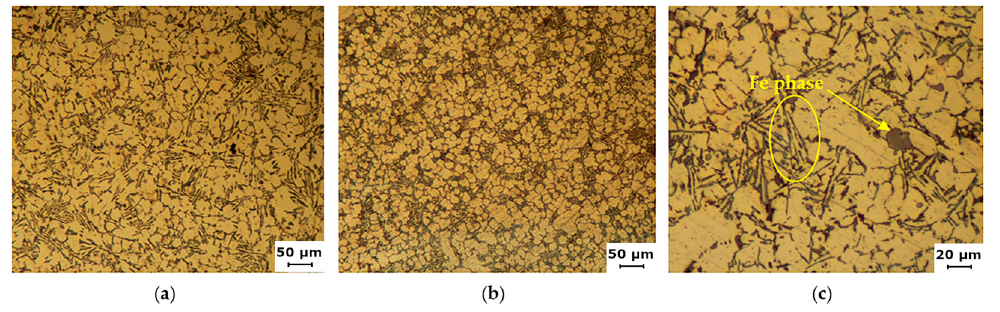
Figure 11. Hat part microstructure: ( a ) SB 120—2 m.s − 1 ; ( b ) SB 55—2 m.s − 1 . ( c ) Plates and polyhedrons of Fe phase.